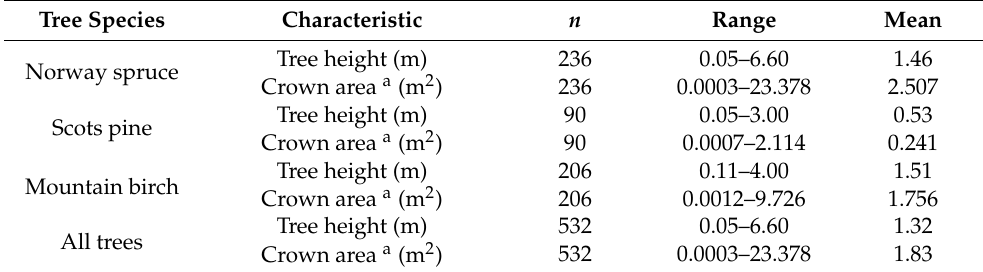
Table 1. Summary of field measurements of 532 trees recorded in 2017. Tree